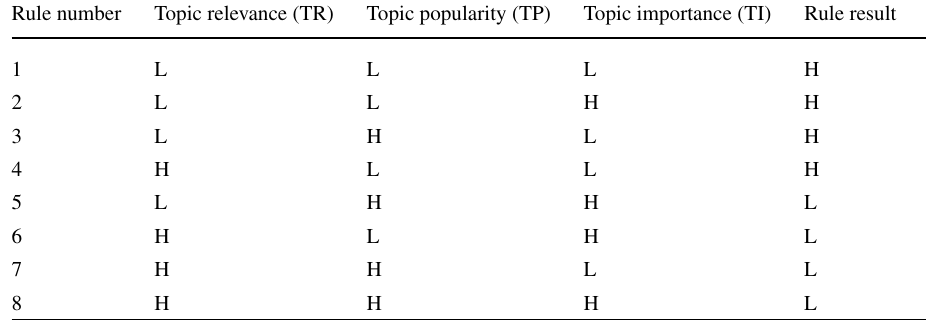
Table 2 The fuzzy rules for three topic indicators Rule number Topic relevance (TR) Topic popularity (TP) Topic importance (TI) Rule